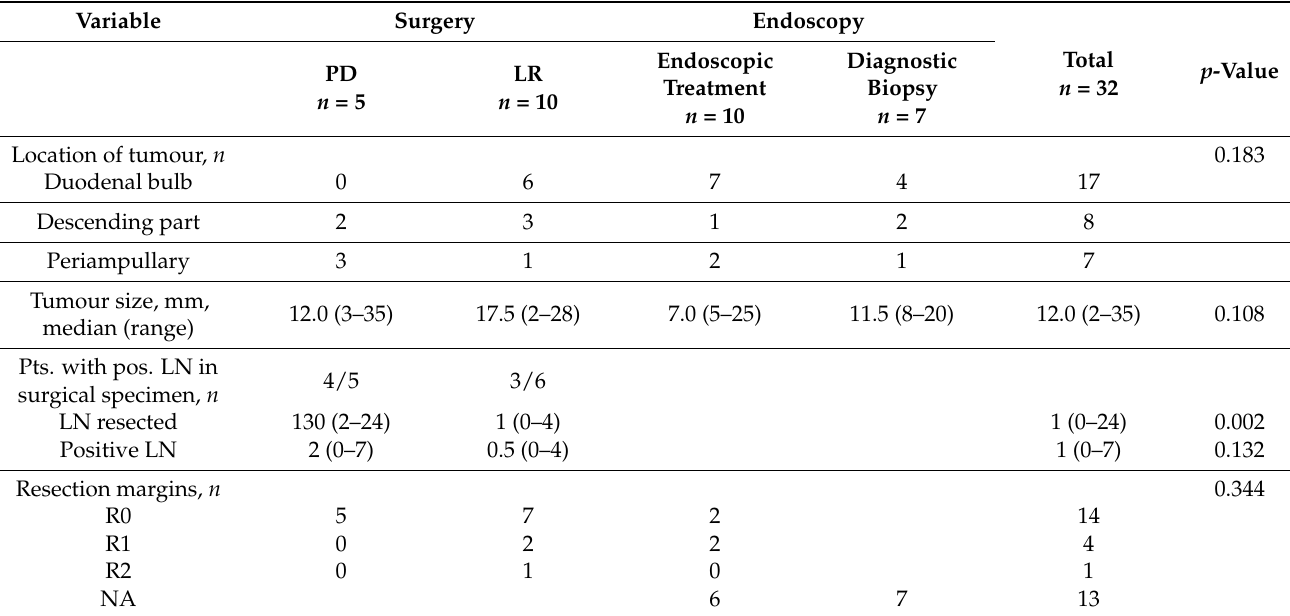
Table 2. Tumour and histopathological characteristics of patients with D-NETs.